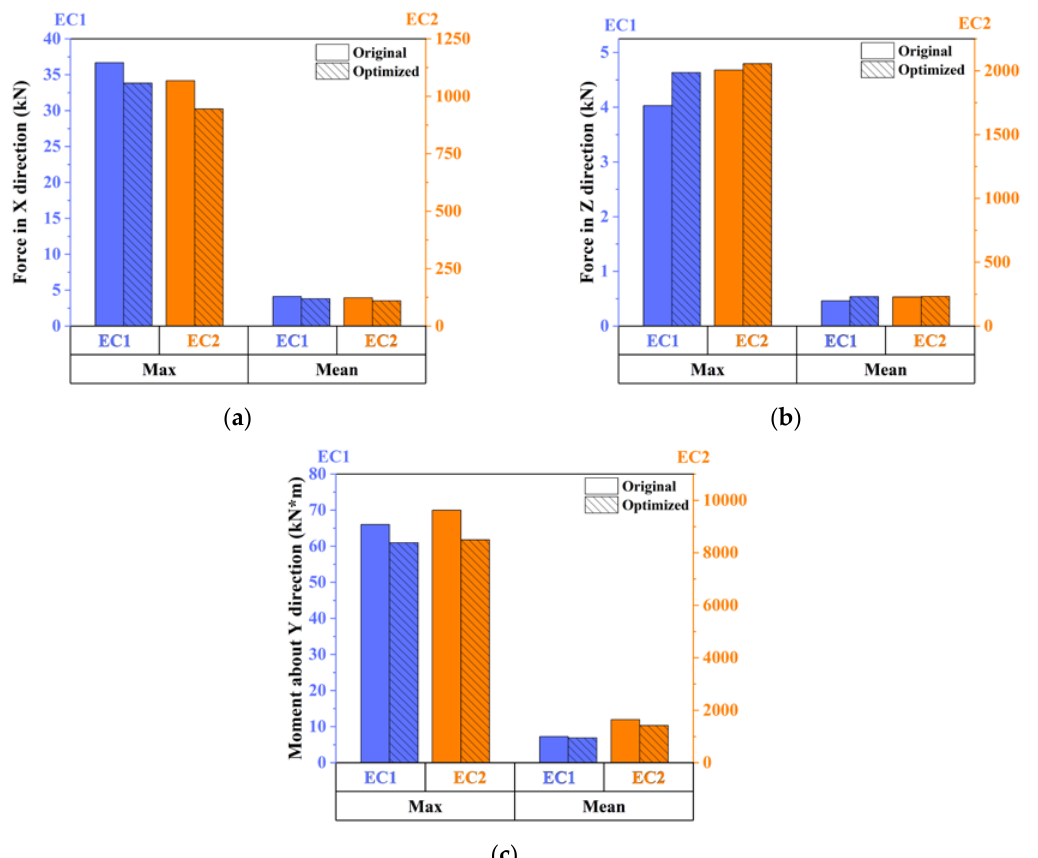
Figure 13. The statistics of the mean drift forces experienced by the two wind turbines under two environmental conditions: ( a ) The force in the X direction; ( b ) the force in Z direction; ( c ) the moment about Y direction.